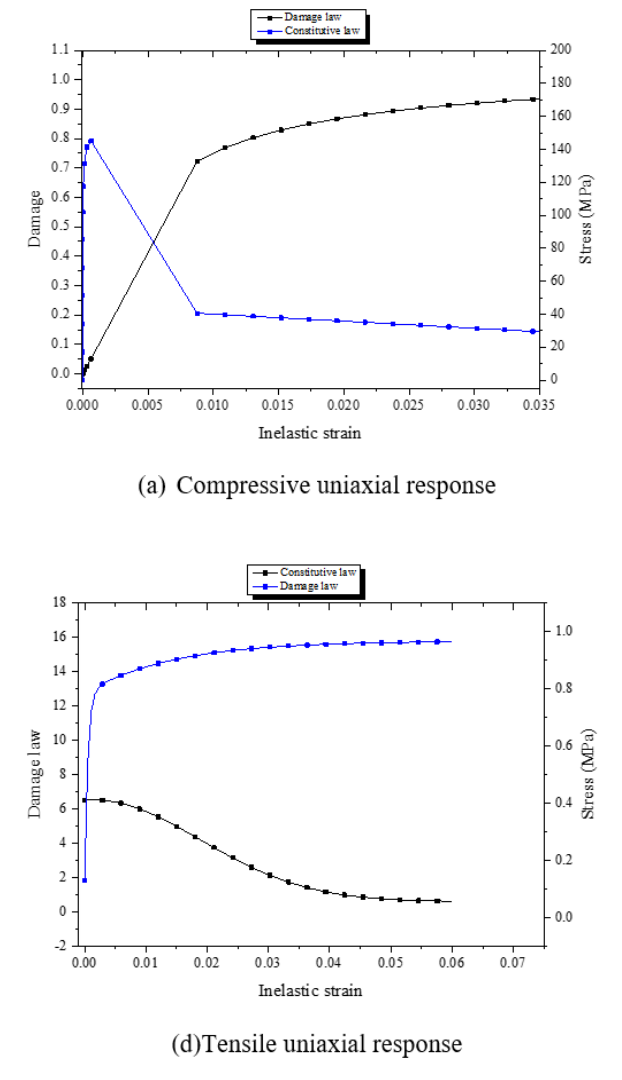
Figure 6. (a) e (d) UHPFRC constitutive model - Krahl et al. [17], [18]